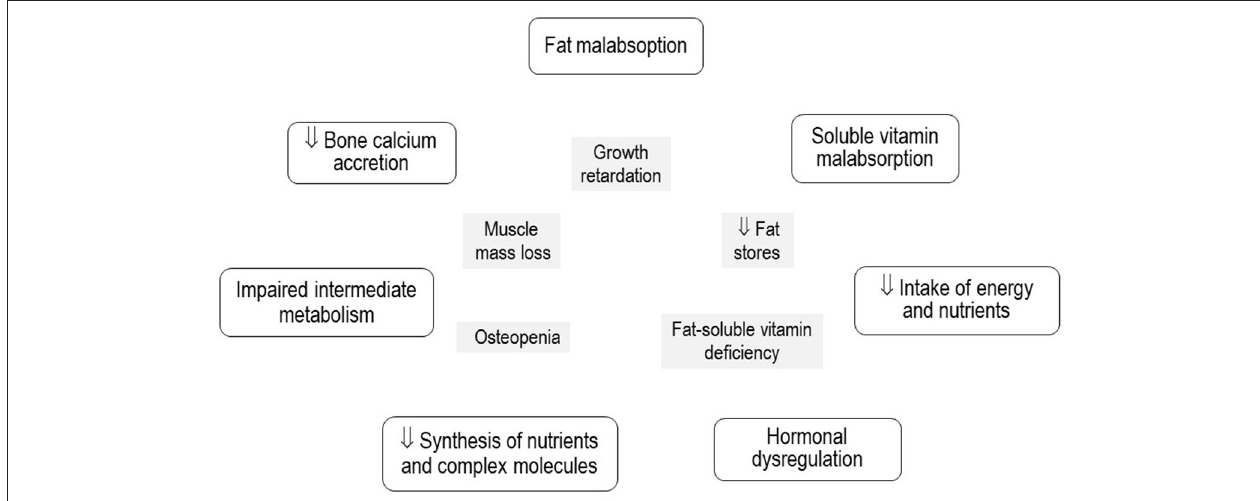
FIGURE 1 | Pathophysiological mechanisms of secondary malnutrition and its expression in growth, body composition, and nutritional status of micronutrients in infants with chronic cholestatic liver